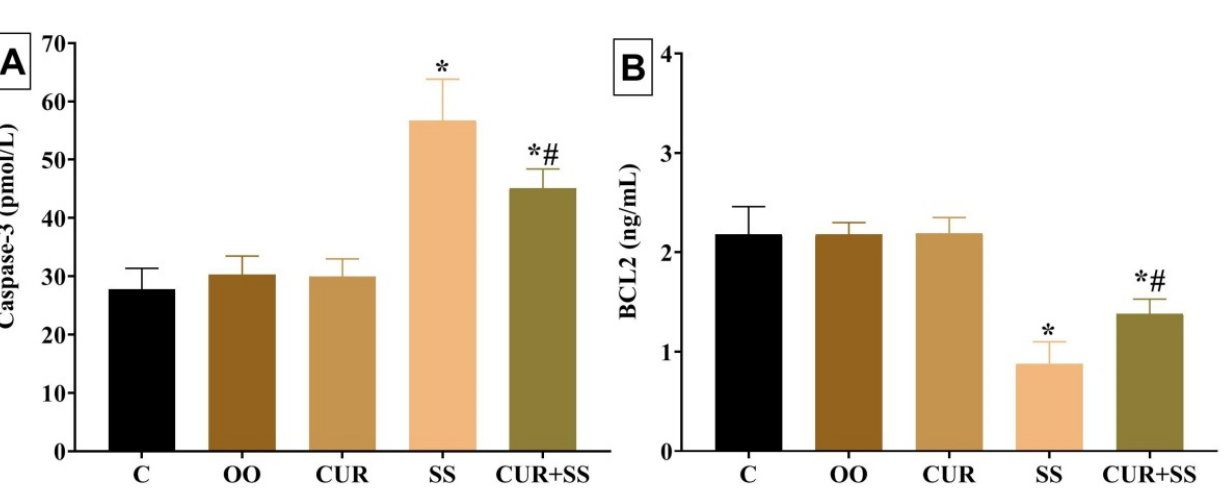
Figure 2. Effect of curcumin (CUR) oral dose on Caspase-3 ( A ) and BCL-2 ( B ) in the kidney tissues of sodium salicylate (SS)-injected rats for 15 days. C: control group. OO: olive oil. Data are expressed as mean ± SD, n = 10 for each group. * Significantly different compared to the control groups at p < 0.05. # Significantly different from the SS-treated group at p <